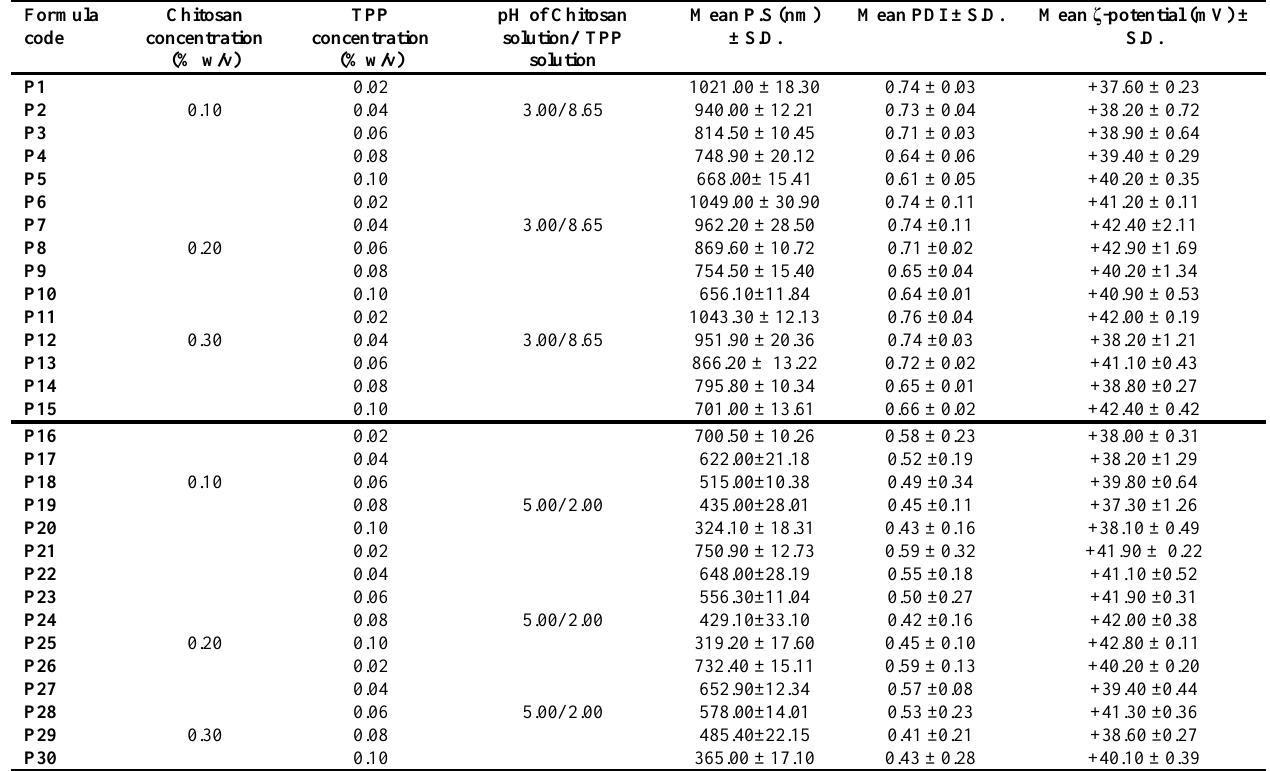
Table 1. Effect of composition on the colloidal properties of drug-free CSNPs before and after pH adjustment (mean ± SD, n = 3) Formula